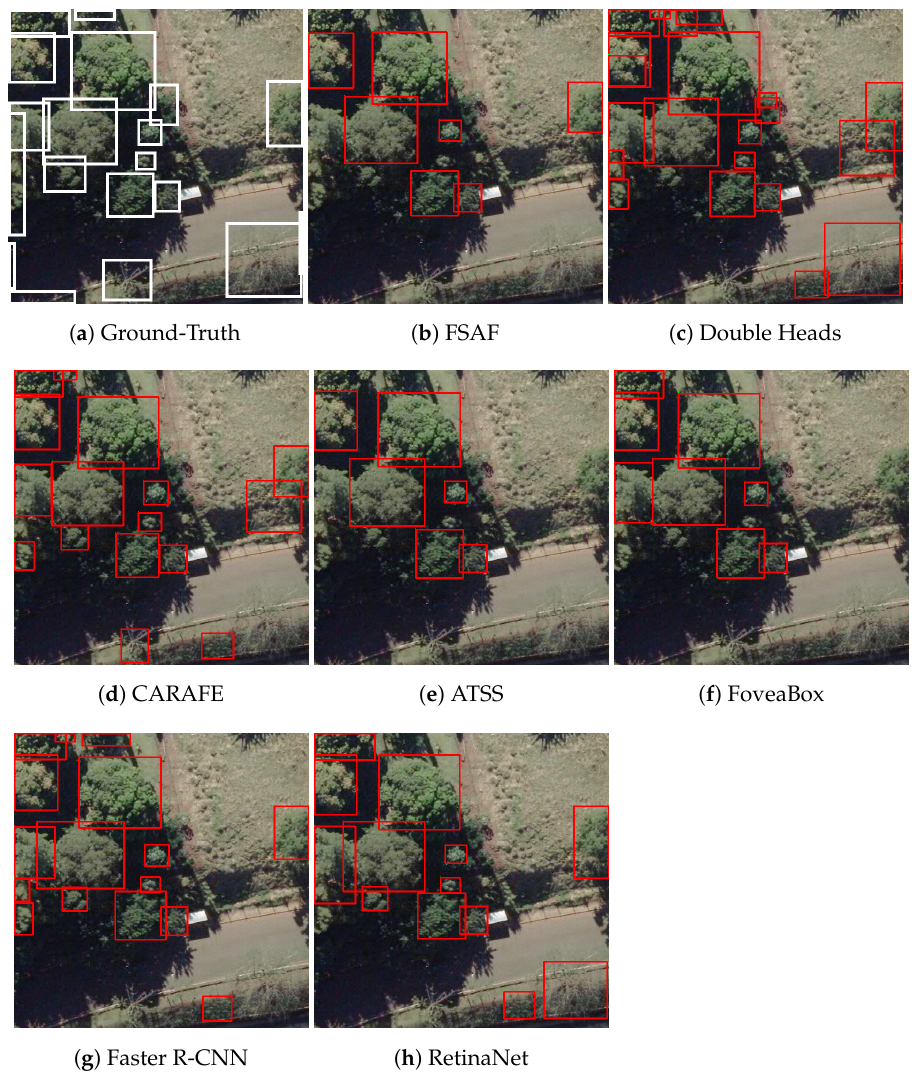
Figure 15. Tree detection with the top five methods, RetinaNet, and Faster R-CNN: performance in a challenging illumination scenario with